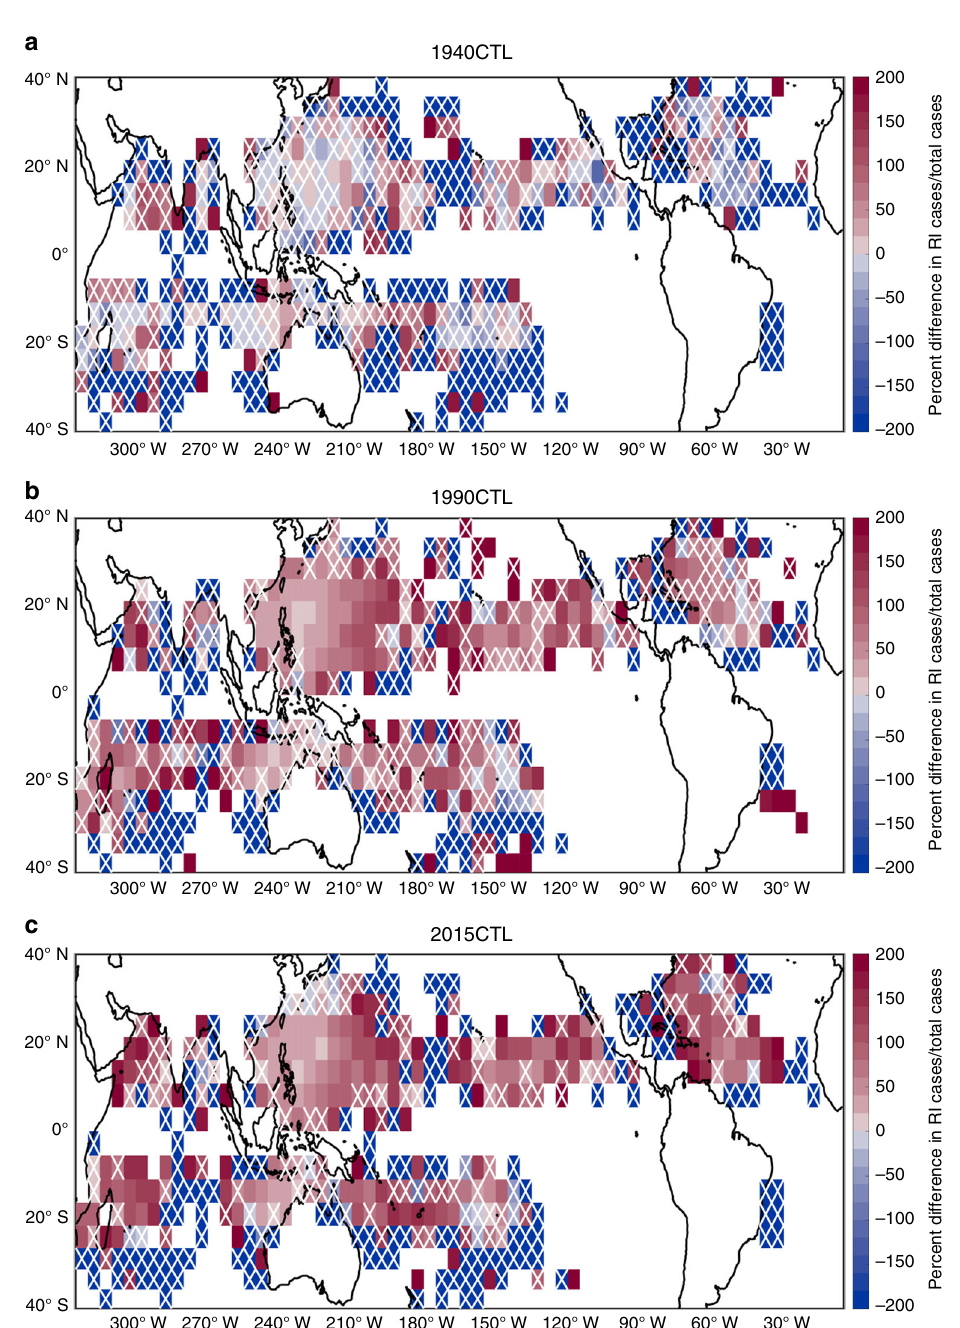
Fig. 6 Anthropogenic forcing ’ s effects on RI ratio in HiFLOR. a – c Simulated changes in RI ratio by the 1940CTL ( a ), 1990CTL ( b ), and 2015CTL ( c ) relative to the 1860CTL. Percent difference in RI ratio between HiFLOR 1860CTL and each climate change simulation is plotted in each 5° × 5° grid box. Data is only plotted in a grid box if at least one TC passes through the grid box every 50 years in the two experiments used to calculate percent difference. Red (blue) squares indicate grid boxes where a larger (smaller) percentage of 24-h intensity changes exceed 30 knots in the climate change simulations than in the 1860CTL. Grid boxes that achieve a p value of 0.05 using a binomial proportion test are considered statistically signi fi cant. White “ Xs ” are located in grid boxes that are not statistically signi fi